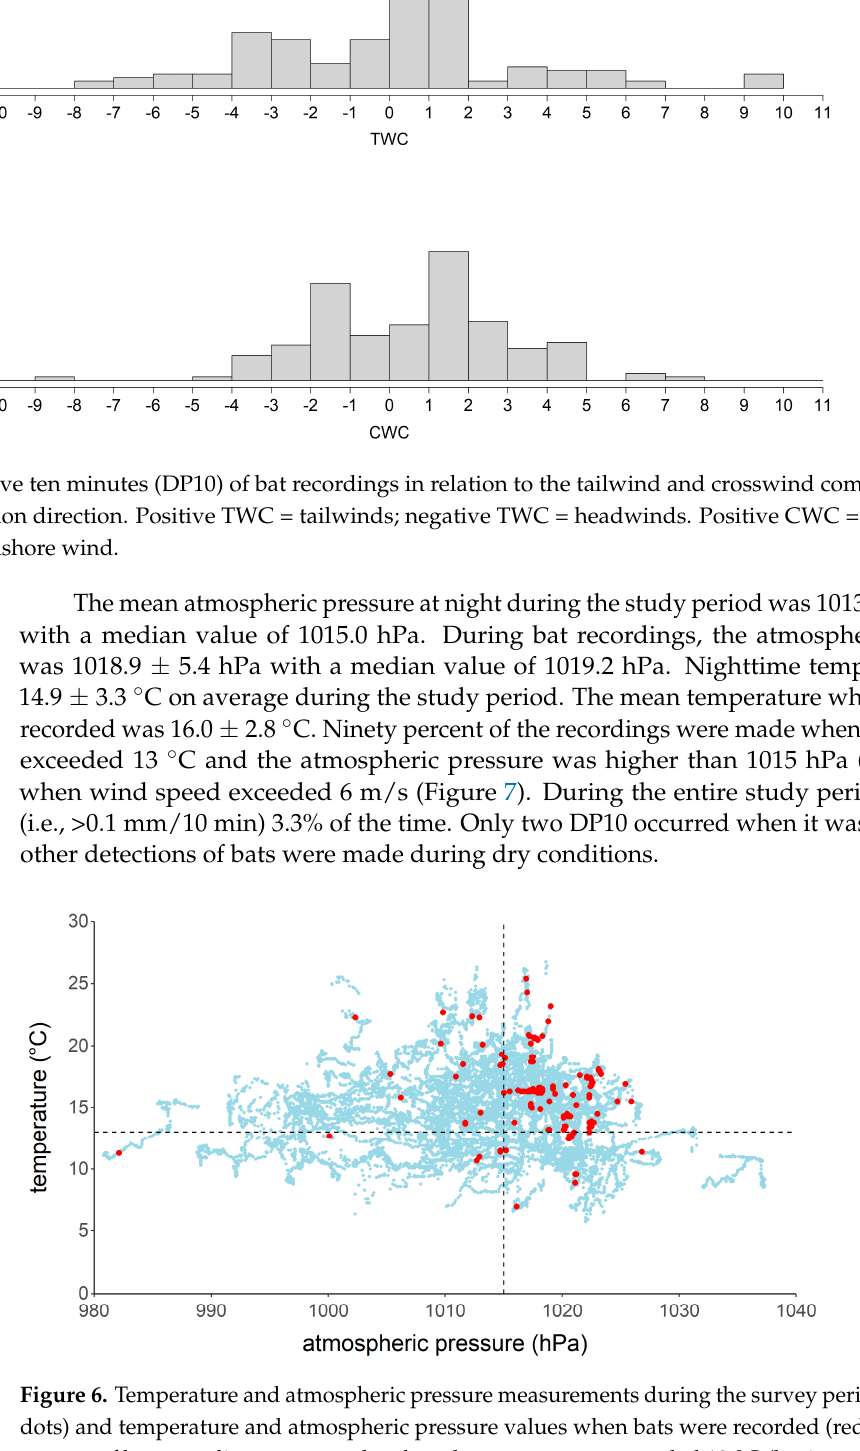
Figure 7. Temperature and wind speed measurements during the survey periods (light blue dots) and temperature and wind speed values when bats were recorded (red dots). Ninety percent of bat recordings were made when the temperature exceeded 13 °C (horizontal dashed line) and wind speed was lower than 6 m/s (vertical dashed line). 4. Discussion Bats were recorded from the end of August until mid-November in 2017 and from the beginning of August until the end of October in 2020. In both years, the number of recordings was highest in September with 75% and 93% of the recordings in 2017 and 2020, respectively. This coincides with the known migration peak period for Nathusius’ pipistrelle (i.e., mid-August to mid-October) [17,23]. Less detections than expected were recorded in August 2017 (study started 8 August), i.e., two DP10. As the weather in August 2017 was colder than average and with a lot of precipitation, we expect that the migration period of bats started later than on average.